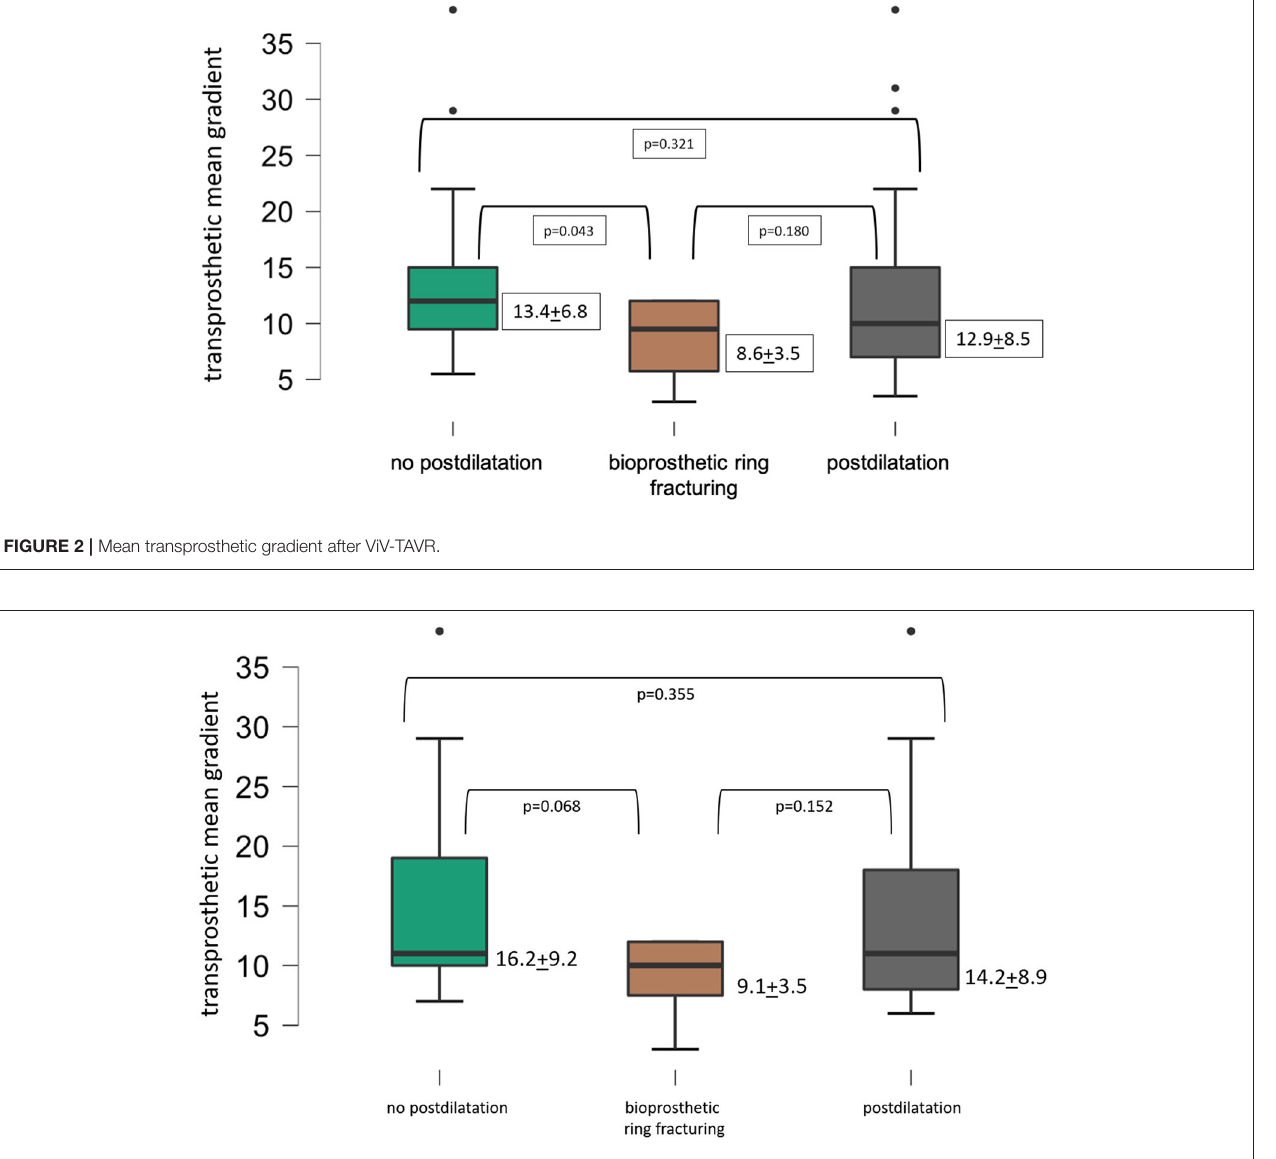
Frontiers in Cardiovascular Medicine |